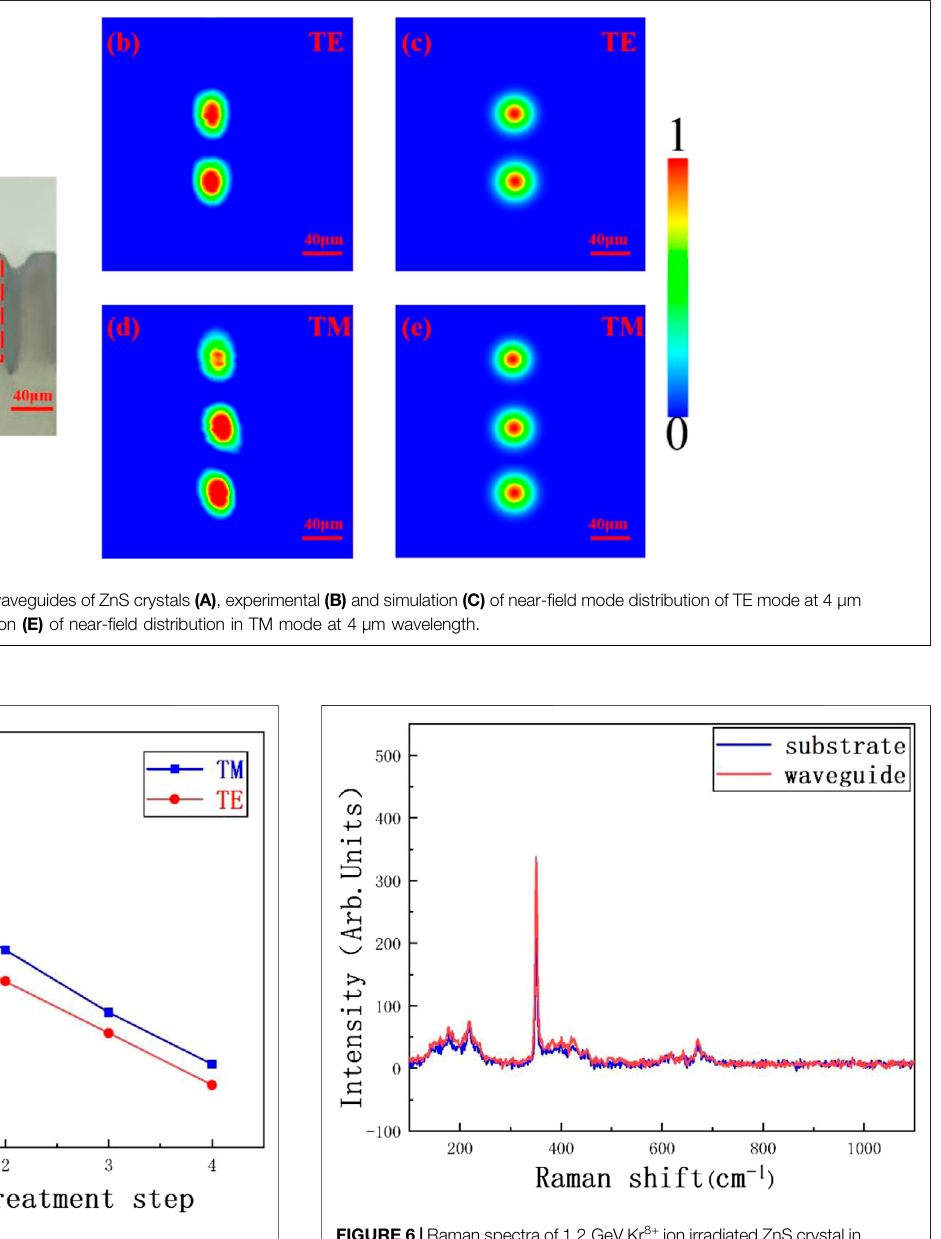
FIGURE 5 | propagation loss of ZnS ridge waveguide in TM (blue line) and TE (red line) modes before and after annealing at 4 μ m wavelength.